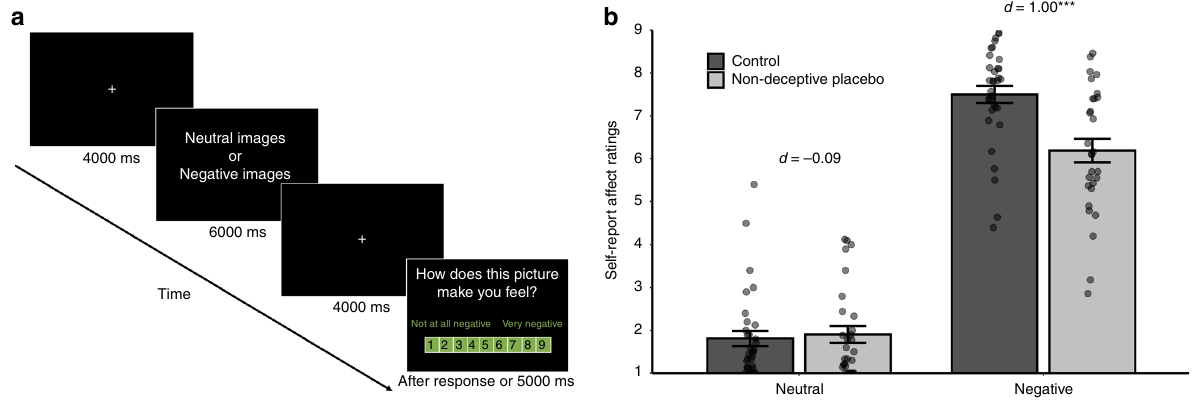
Fig. 1 Experiment 1 trial sequence and results ( n = 62 participants). a All participants viewed a total of 40 images (30 negative and 10 neutral) in one block, and reported how they felt after each image on a nine-point scale from 1 (not at all negative) to 9 (very negative). b A mixed-factorial ANOVA (condition by picture type) was conducted followed-up by independent pairwise comparisons for relevant contrasts. All tests were two-tailed, and follow- up tests were not adjusted for multiple comparisons. Bars represent the mean self-report ratings calculated for condition (control group, n = 33, and non- deceptive placebo group, n = 29) per picture type (neutral and negative). Error bars represent ± 1 SEM. Dots represent mean values for each participant per picture type. There was a signi fi cant interaction between condition and picture type ( p = 0.0008). Follow-up tests showed no difference in emotional distress ratings between the control group and non-deceptive placebo group for neutral pictures ( p = 0.72); however, the non-deceptive placebo group, compared to the control group, reported less emotional distress when viewing negative pictures ( p = 0.0002). No asterisk = not signi fi cant, *** p <